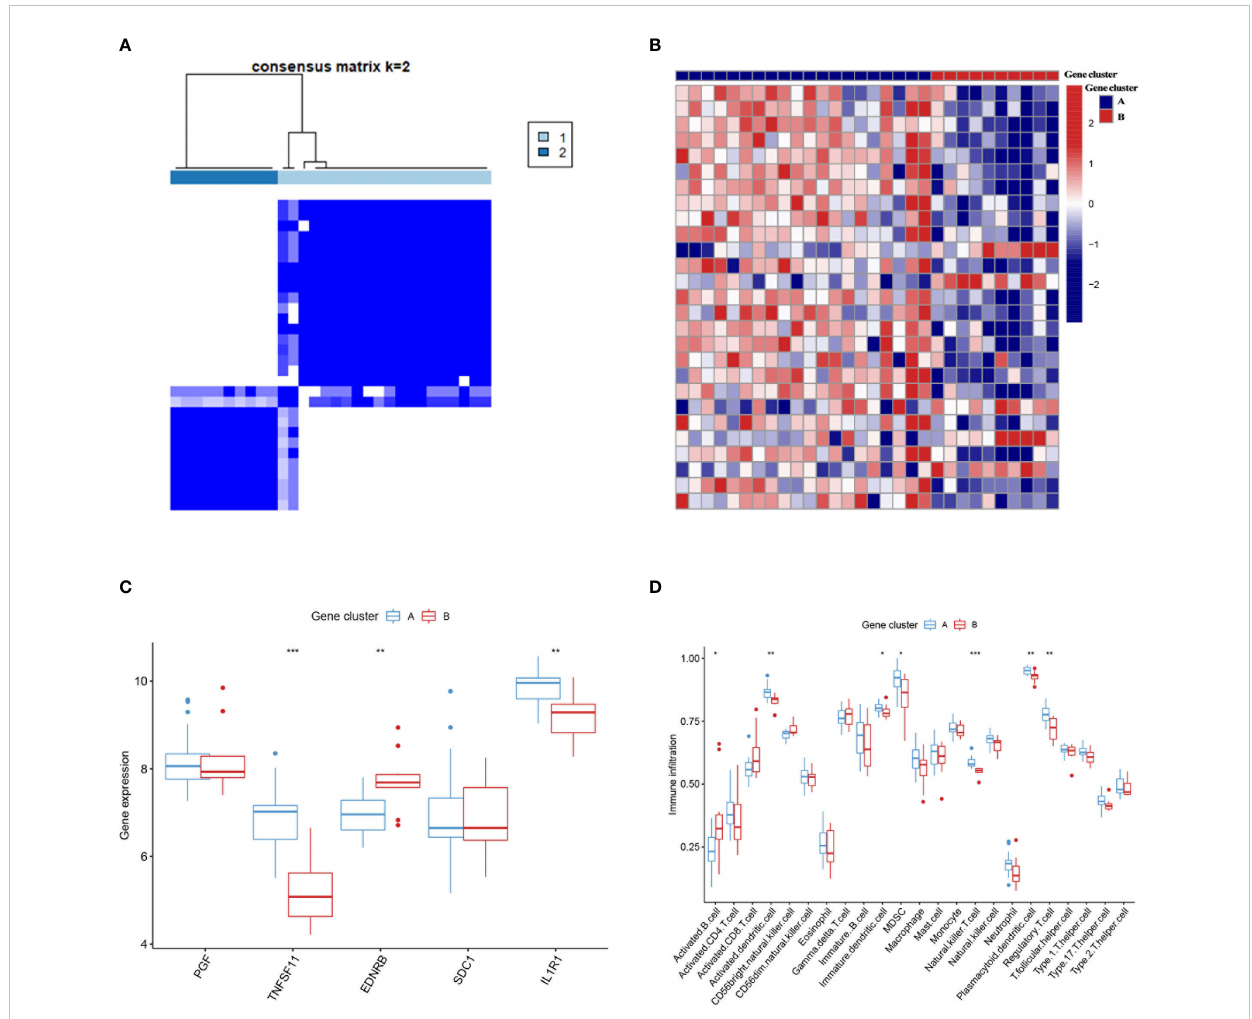
FIGURE 4 External validation for the two immune subtypes in GSE55457. (A) Two immune subtypes were found in GSE55457 by clustering analysis. (B) The heatmap showed the differentially expressed genes between the two subtypes. (C, D) The two immune subtypes differ in the pattern of immune gene expression (C) and immune cell in fi ltration (D) . Cluster B also displayed higher in fi ltration of activated B cells and T cells as the subtype B in GSE55235. * means P < 0.05, ** means P < 0.01, *** means P <